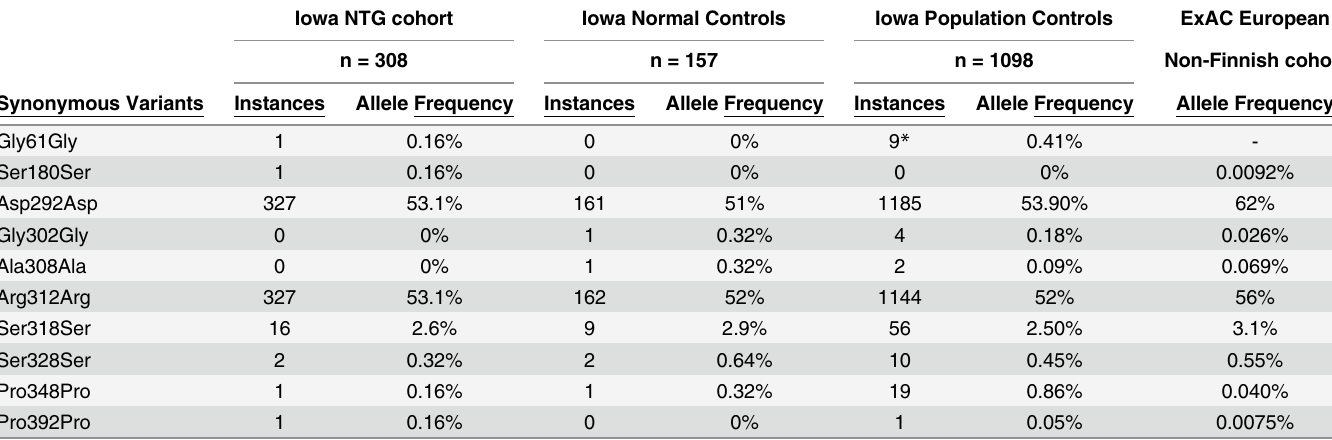
Table 4. Synonymous SQSTM1